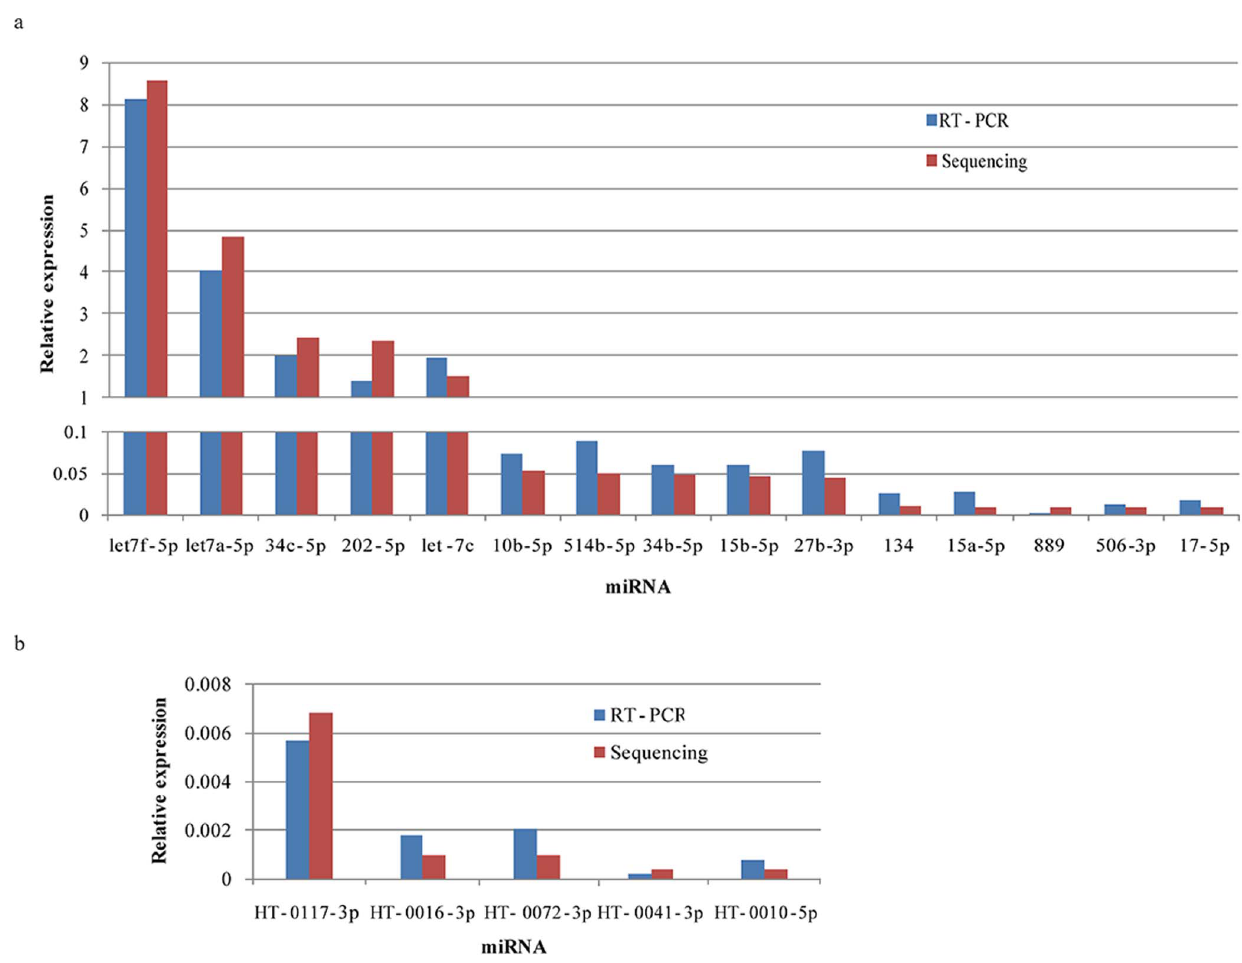
Figure 3. Confirmation of miRNA expression by qRT-PCR. a) Validation of the expression of fifteen known miRNAs belonging to three expression levels (high, median, low); b) Validation of the expression of the 5 novel miRNAs. (Table 3 and Table S4). After GO analysis, KEGG was used to construct a pathway enrichment of predicted miRNA target genes. Many signaling pathways were found to be involved, including meiosis and p53 signaling (Table S5).